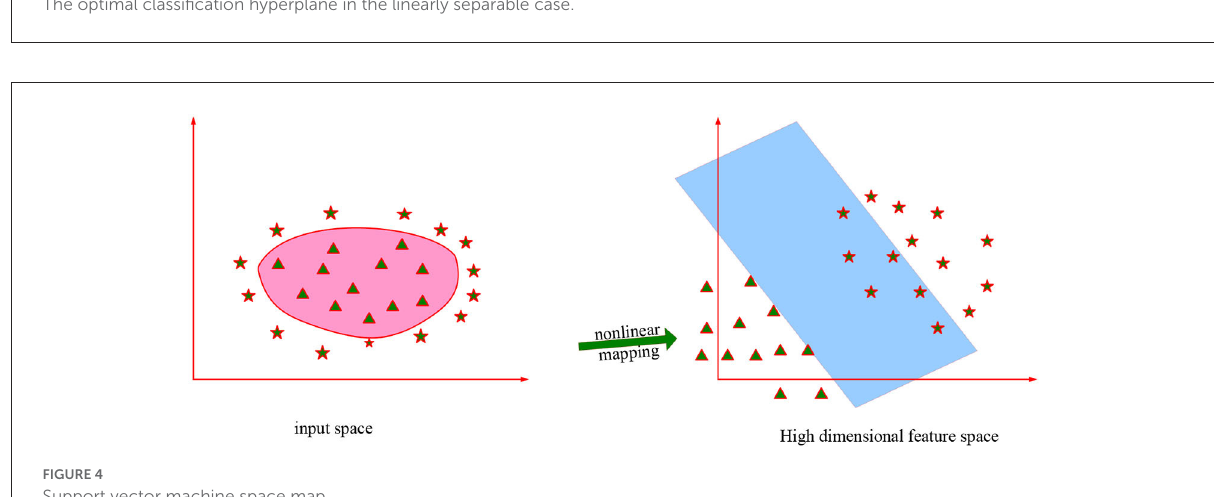
FIGURE4 Support vector machine space